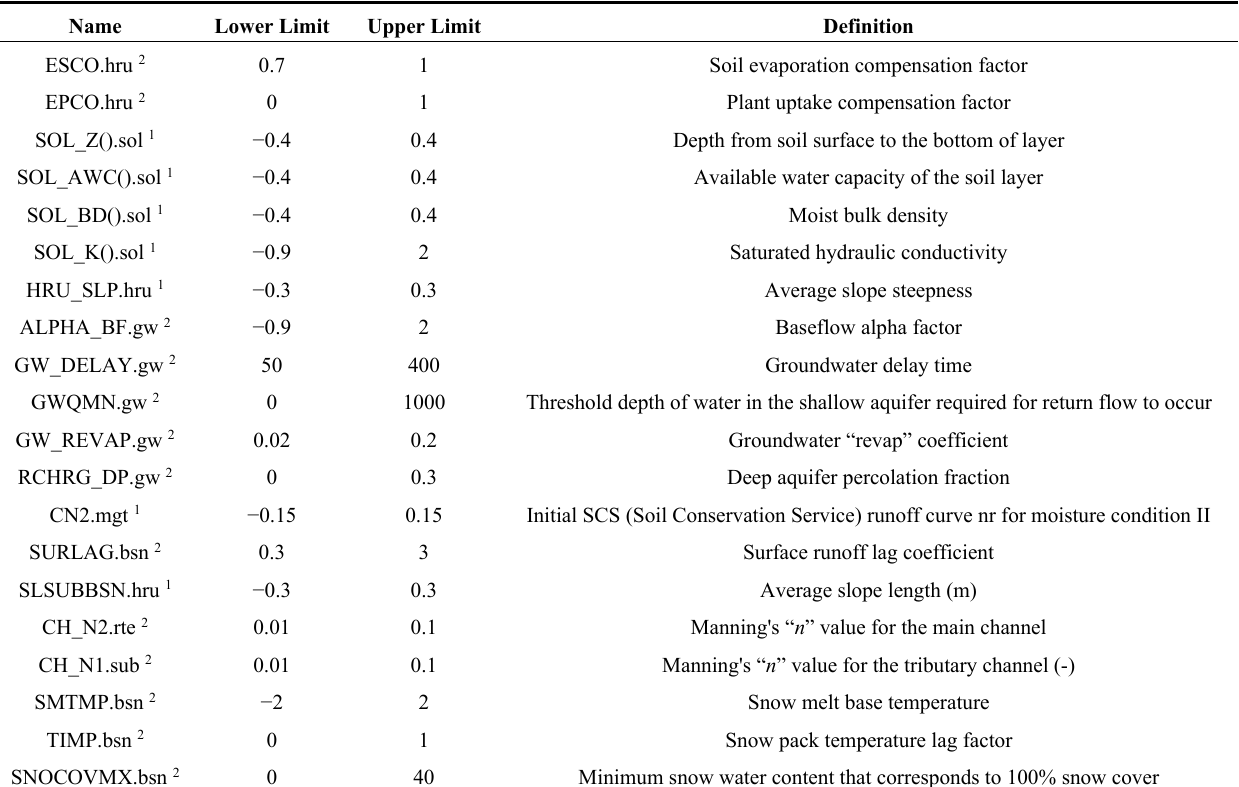
Table 1. Parameter definitions and initial ranges used in